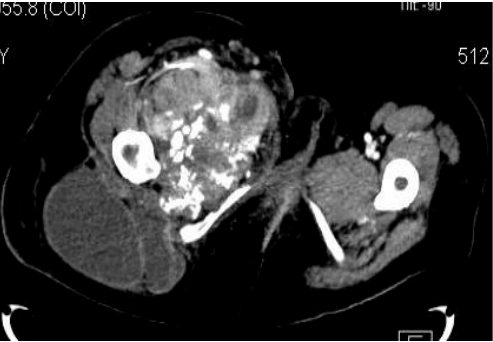
Figure 5. Synovial sarcoma, F, 31 YO patient—CT image, axial section: soft-tissue mass with heterogeneous content, showing necrotic areas alternating with calcifications and cystic areas.